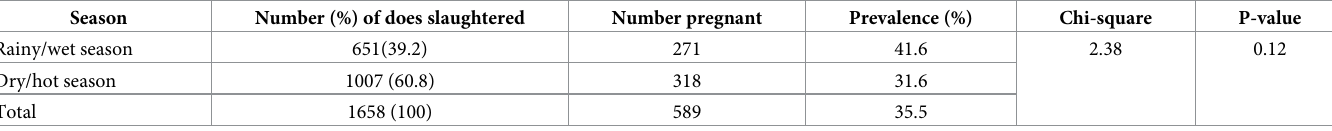
Table 2. Seasonal distribution and pregnancy status of female goats slaughtered for meat in Enugu, Nigeria. Season Number (%) of does